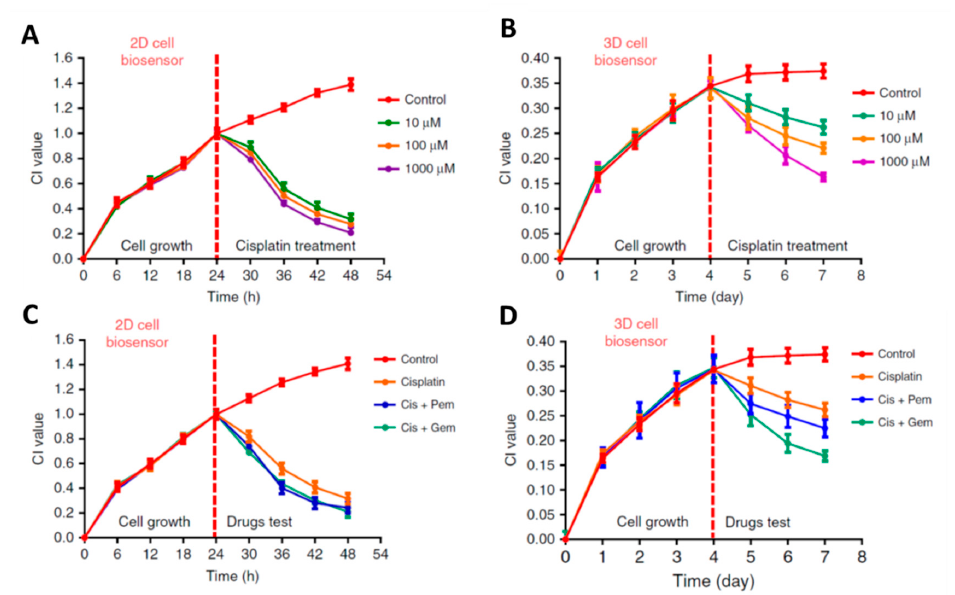
Figure 15. Real-time monitoring of the effects of cisplatin (Cis) on lung cancer cells in ( A ) 2D in vitro and ( B ) 3D in vitro models. Evaluation of the combination treatment of Cis with gemcitabine (Gem) and Cis with pemetrexed (Pem) on lung cancer cells in ( C ) 2D in vitro and ( D ) 3D in vitro model. The cell index (CI) values were calculated from the developed CBI sensor. With permission under the terms of the Creative Commons CC BY license from Springer Nature [71].